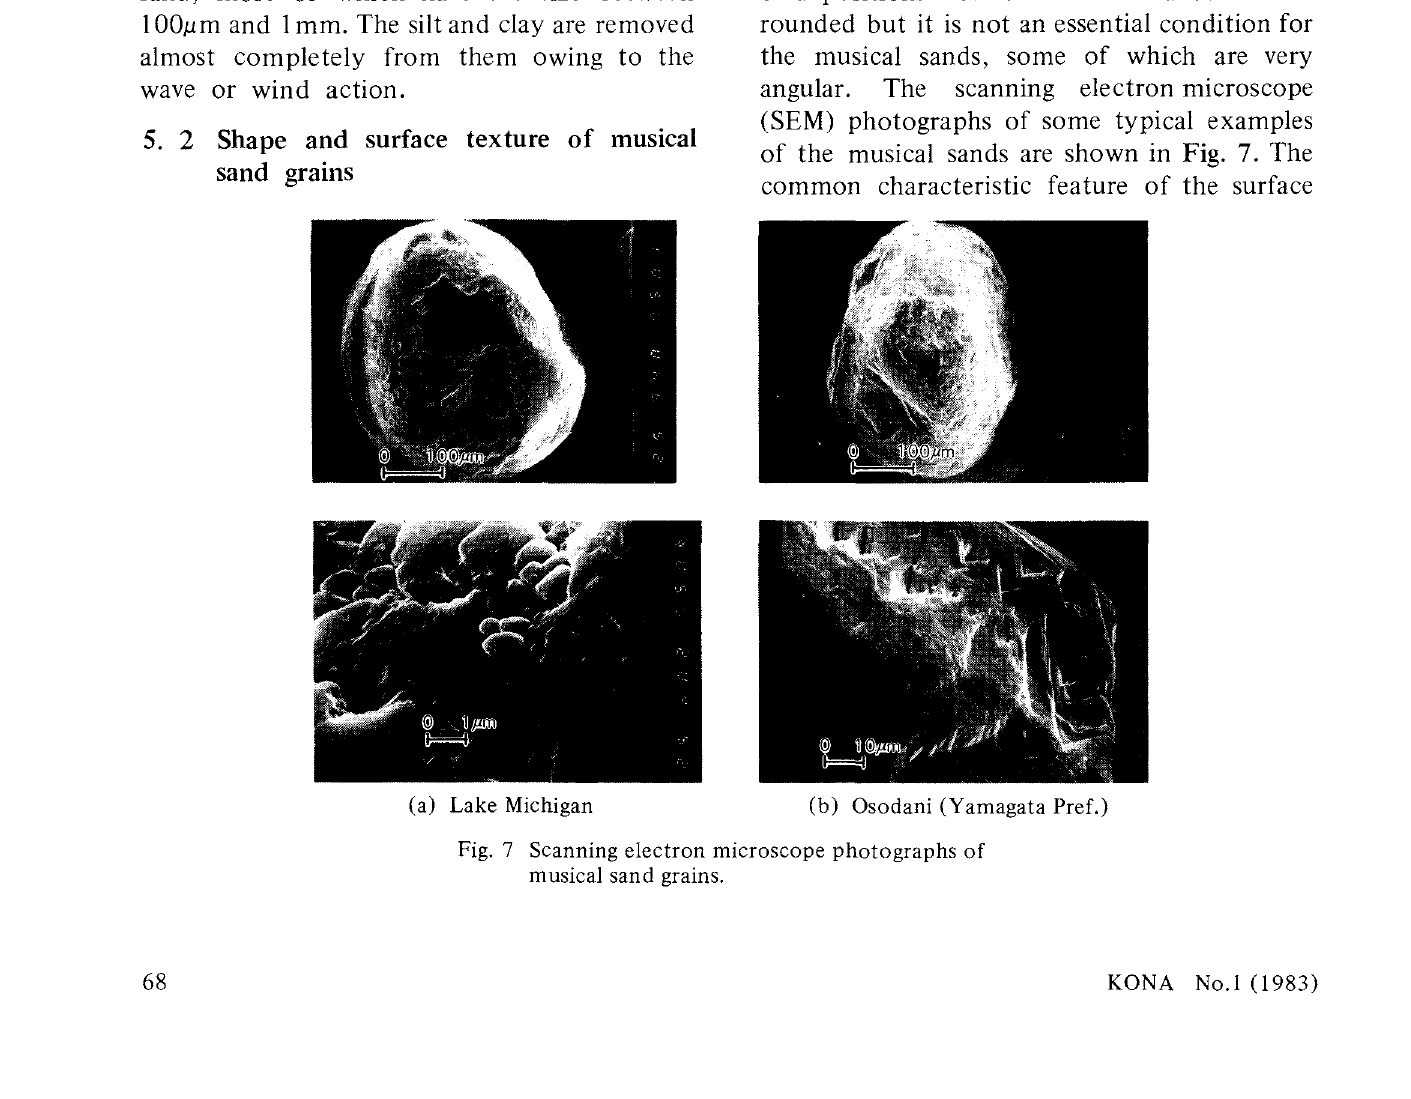
Fig. 7 Scanning electron microscope photographs of musical sand